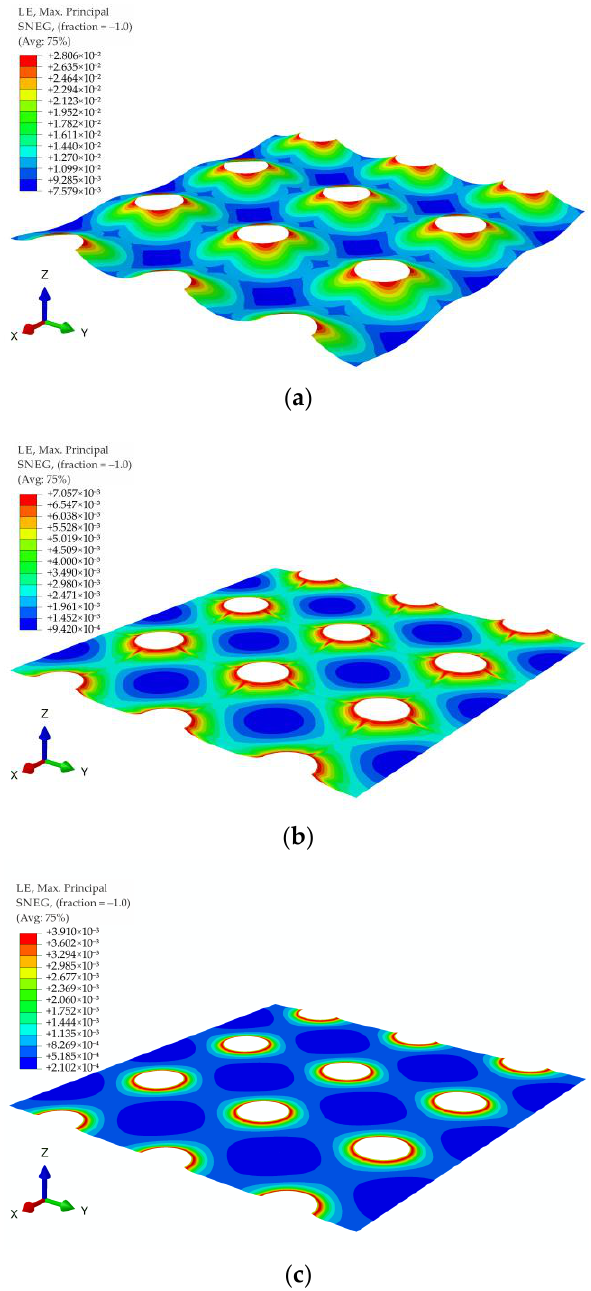
Figure 22. Deformation and maximum principal strain in reinforcement, variant B1: ( a ) k = 10 kN/m 3 ; ( b ) k = 150 kN/m 3 ; ( c ) k = 500 kN/m 3 .